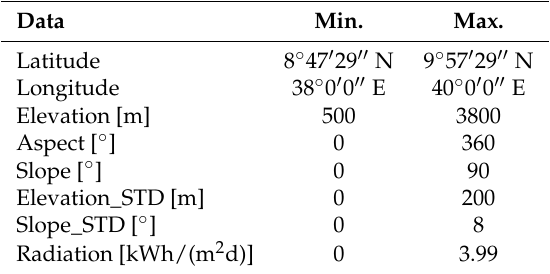
Table 1. Ranges of Adaptive Neuro-Fuzzy Inference System (ANFIS) training data (matrix of 219 columns and 130